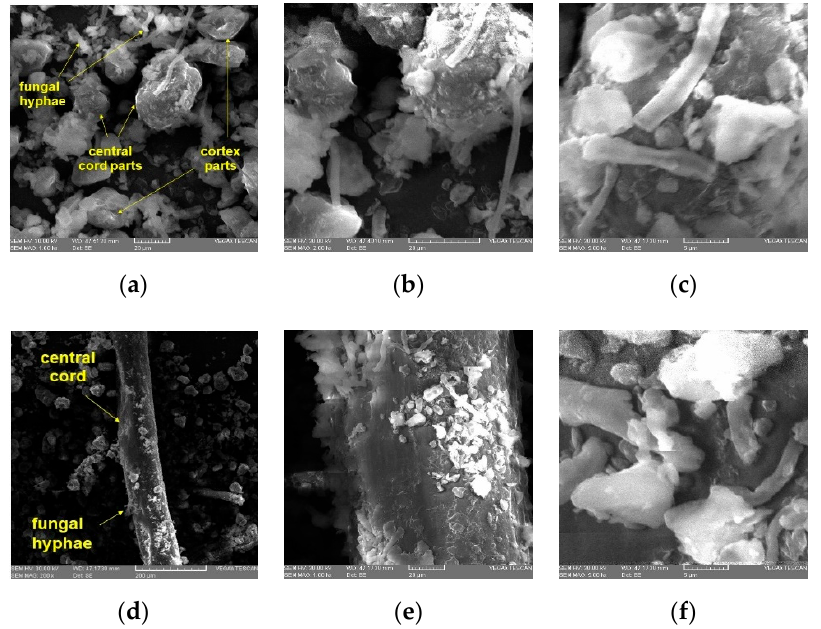
Figure 4. SEM micrographs in d UB (particle size > 315 μ m): ( a – c ) cortex fragments, central cord, and fungal hyphae, at different magnifications: ( a ) 1 k× (scale bar = 20 μ m), ( b ) 2 k× (scale bar = 20 μ m), fungal hyphae, at different magnifications: ( a ) 1 k × (scale bar = 20 µ m), ( b ) 2 k × (scale bar = 20 µ m), ( c ) 5 k× (scale bar = 5 μ m); ( d – f ) central cord with fungal hyphae between cortex fragments, at ( c ) 5 k × (scale bar = 5 µ m); ( d – f ) central cord with fungal hyphae between cortex fragments, different magnifications: ( d ) 200 k× (scale bar = 200 μ m), ( e ) 1 k× (scale bar = 20 μ m), ( f ) 5 k× (scale at different magnifications: ( d ) 200 k × (scale bar = 200 µ m), ( e ) 1 k × (scale bar = 20 µ m), bar = 5 μ m). ( f ) 5 k × (scale bar = 5 µ